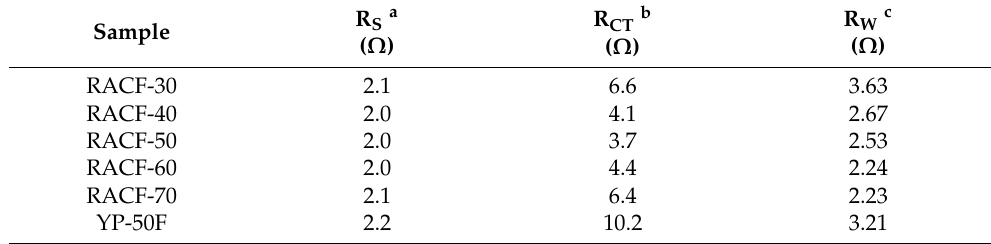
Table 2. Values of equivalent circuit parameters from the fitting of the impedance spectra in Figure 7.